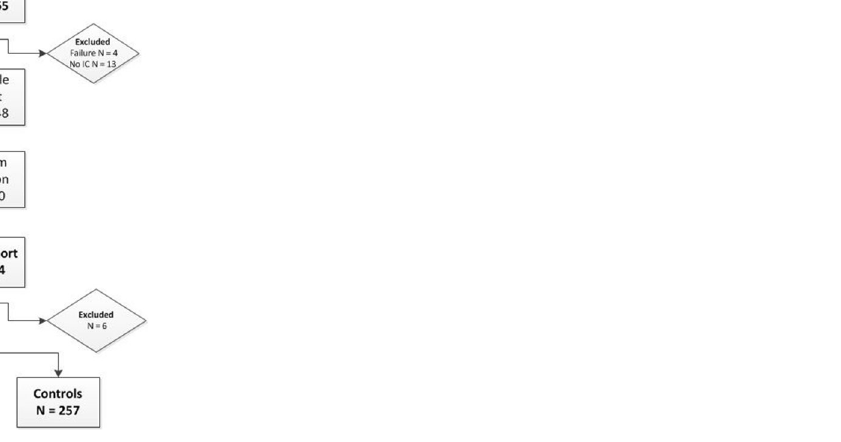
Figure 1. Flowchart patient selection. Original data from myomarker cohort. IC informed